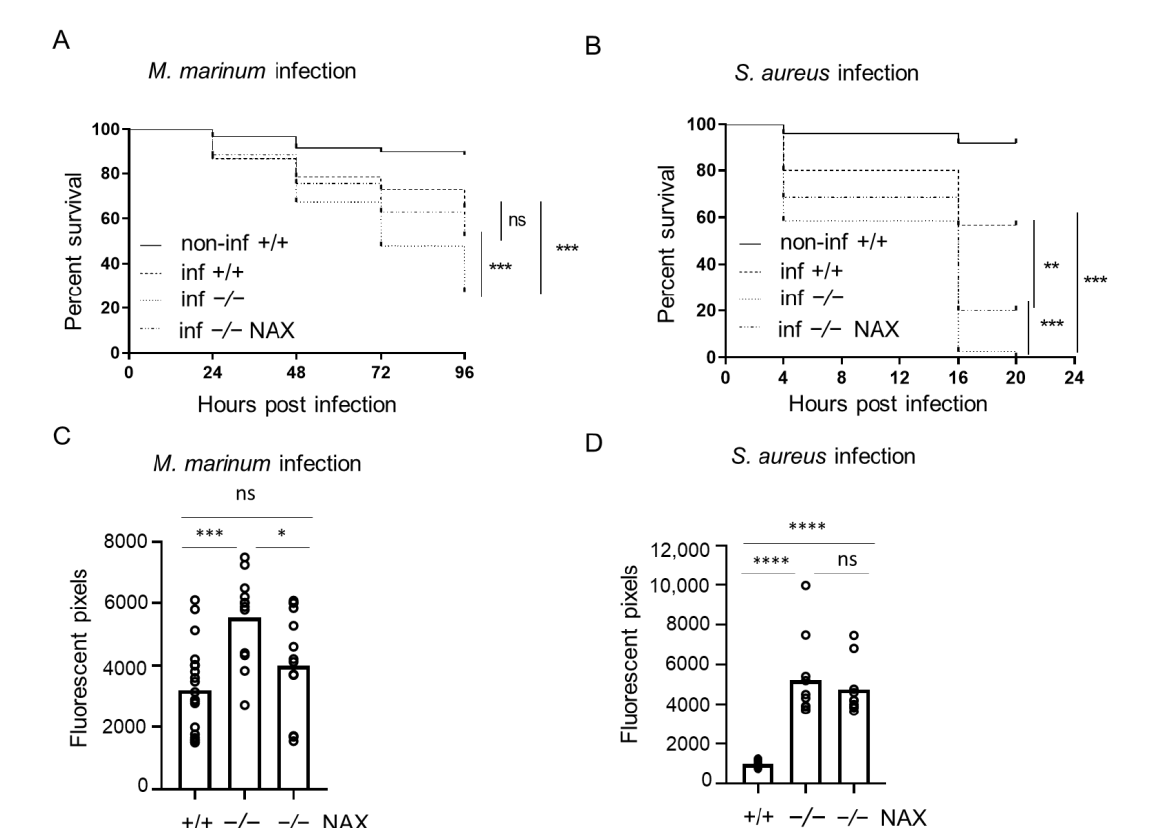
Figure 1. Galanin deficiency results in higher mortality and bacterial burden after yolk infection. ( A , B ) Survival rate in mock-injected larvae (non-inf +/+), infected wild-types (inf +/+), infected gal − / − mutants (inf -/-) and infected gal − / − mutants treated with NAX 5055 (inf -/- NAX) after ( A ) M. marinum or ( B ) S. aureus yolk infection. ( C , D ) Bacterial burden in infected wild-type larvae, infected gal − / − mutants and infected gal − / − mutants treated with NAX 5055 after ( C ) M. marinum or ( D ) S. aureus yolk infection. Data are combined from three biological replicates (n = 10 larvae/group). * p < 0.05; ** p < 0.01; *** p < 0.001; **** p < 0.0001; ns, non-significant.